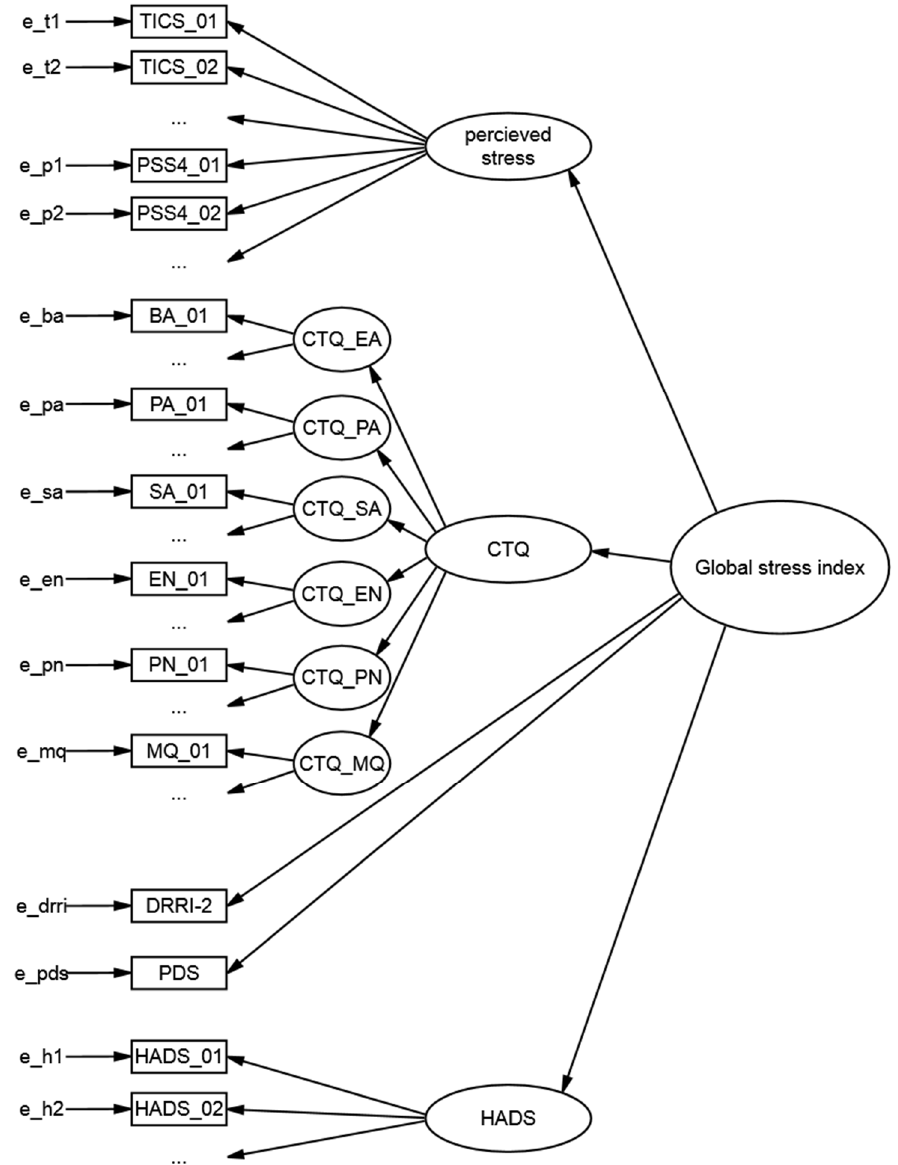
Figure 1. Illustration of the multilevel model results from structural equation modeling. All manifest variables are presented in squares. All latent factors are presented in circles. e = error; PSS4 = Perceived Stress Scale; TICS = Trier Inventory for Chronic Stress; HADS = Hospital Anxiety and Depression Scale; PDS = Posttraumatic Stress Diagnostic Scale Checklist; DRRI_2 = Deployment Risk and Resilience Inventory; CTQ = Childhood Trauma Questionnaire; EA = Emotional Abuse; PA = Physical Abuse; SA = Sexual Abuse; EN = Emotional Neglect; PN = Physical Neglect; MQ = minimization questions.